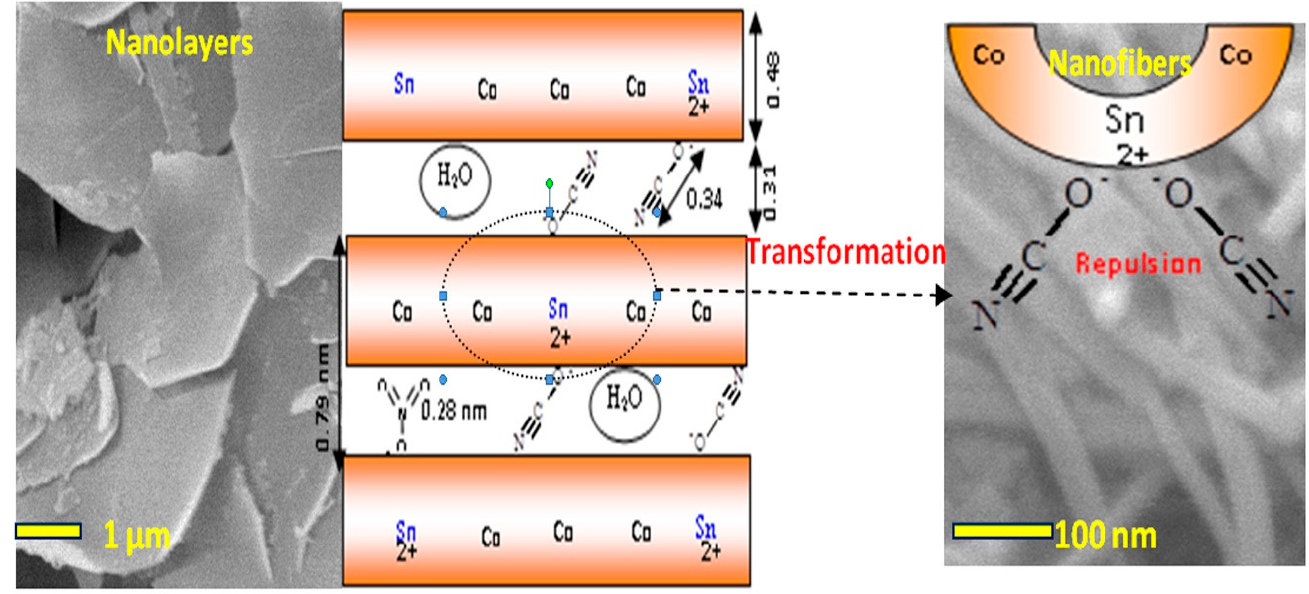
Figure 6. Schematic representation for transformation of nanolayers to nanofibers.